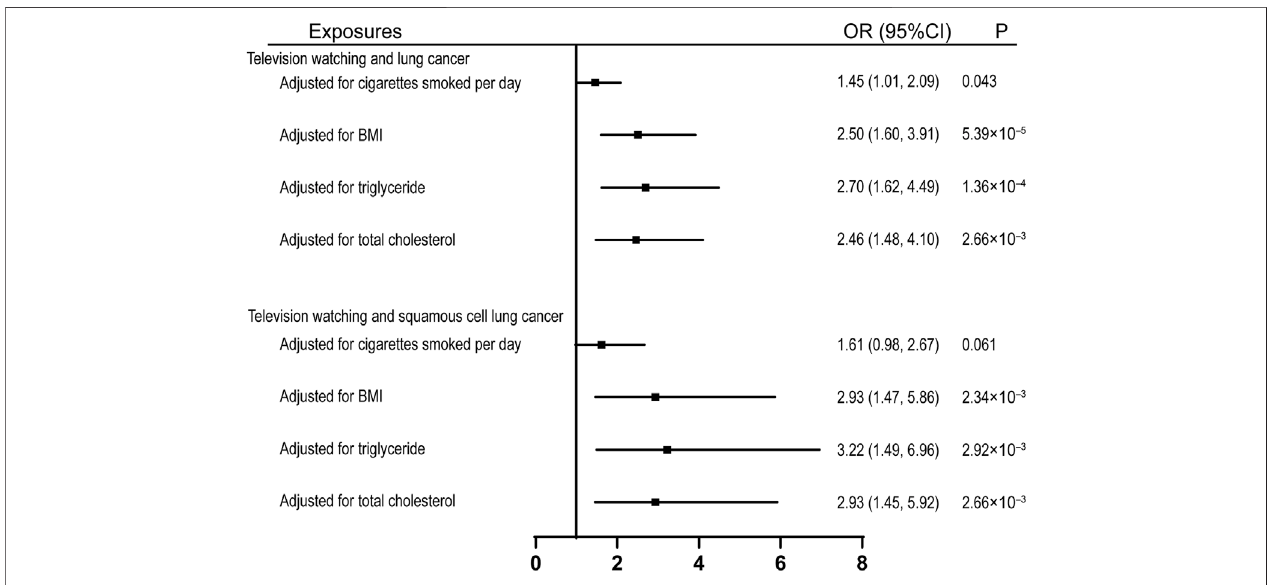
FIGURE 3 | Multivariable MR analyses showing the associations of genetically proxied leisure television watching with overall lung cancer and squamous cell lung cancer after adjusting for common risk factors of lung cancer. BMI, body mass index; OR, odds ratio; CI, con fi dence interval; MR, Mendelian randomization.